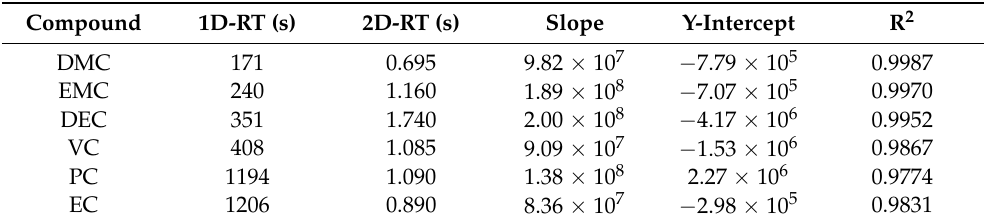
Figure 2. Three-dimensional chromatogram exhibiting effective separation of the carbonates in the 100% calibration solution when using the GC × GC/FID system. Table 3. GC×GC/FID calibration results including the retention times and linear correlation param- eters for common organic solvents found in Li-ion batteries.